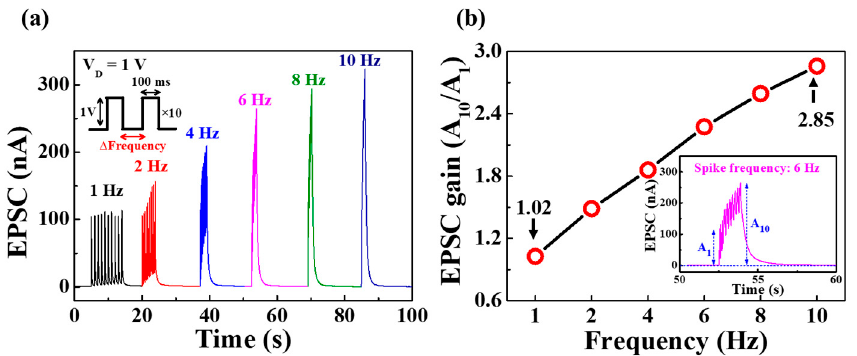
Figure 5. ( a ) EPSC response to consecutive pre-synaptic spikes (1 V, 100 ms) at different frequencies (1 to 10 Hz). ( b ) EPSC gain (A 10 /A 1 ) value. The EPSC response to 6 Hz is shown